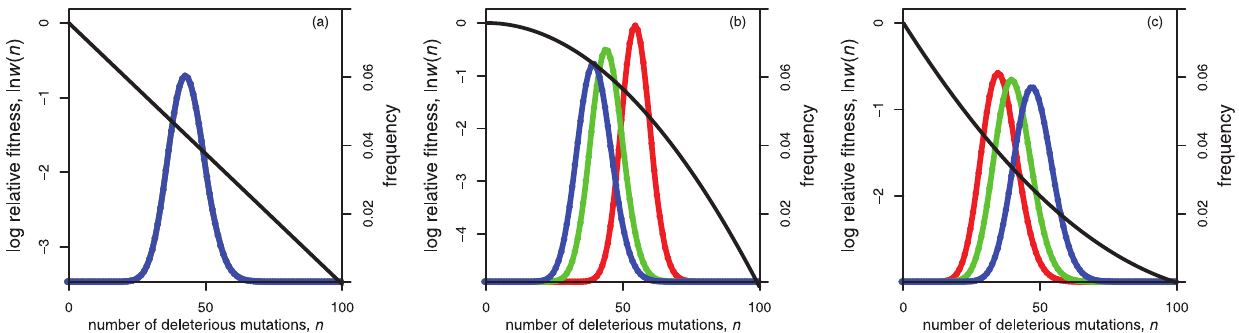
Figure 1. Fitness landscapes and equilibrium frequency distributions. Each plot has two vertical axes. The left-hand-vertical axis gives the natural logarithm of relative fitness, and it relates to the black lines that appear in each plot. The right-hand vertical axis gives the relative frequency of the various genotypic classes, and it relates to coloured lines and points. The three colours give results for asexuality (red), free recombination (blue), and segregation only (green). All three coloured lines occur in exactly the same positions in panel (a) because this plot shows the data when epistasis is absent, in which case all three modes of reproduction lead to the same distribution of genotypic classes. Panel (b) shows a case of negative epistasis, which leads to a disadvantage for asexuality. Panel (c) shows a case of positive epistasis, which leads to an advantage for asexuality. The fitness landscapes shown are from Eq. (1). The parameters used for the three panels were: (a) a 2 ~ 0 : 035 , b ~ 0 ; (b) a 2 ~ 0 , b ~ 0 : 001 ; (c) a